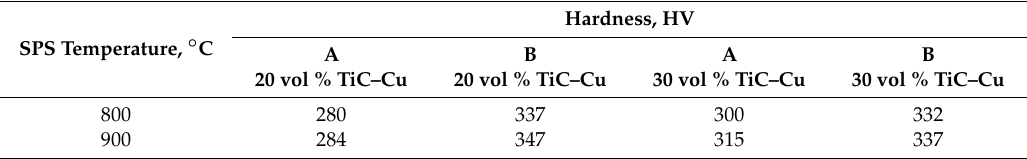
Table 7. Vickers Hardness of the spark plasma sintered TiC–Cu nanocomposites.